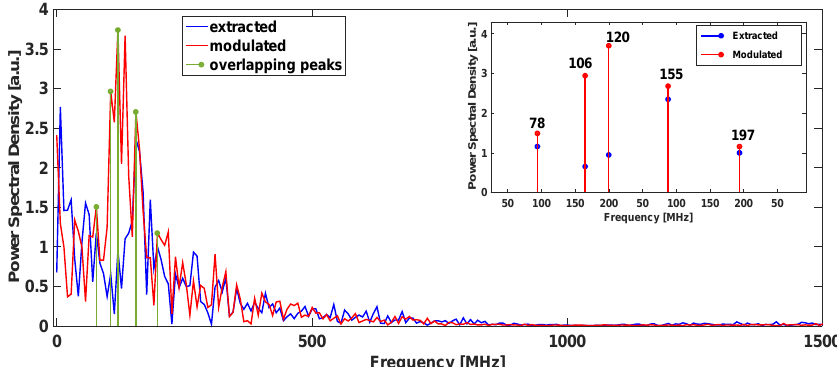
Figure 7. Frequency spectrum of extracted and modulated curves in Figure 6. Peaks occurring at the same frequencies are also plotted. Additionally, the subplot shows values of the same frequencies at which peak overlapping